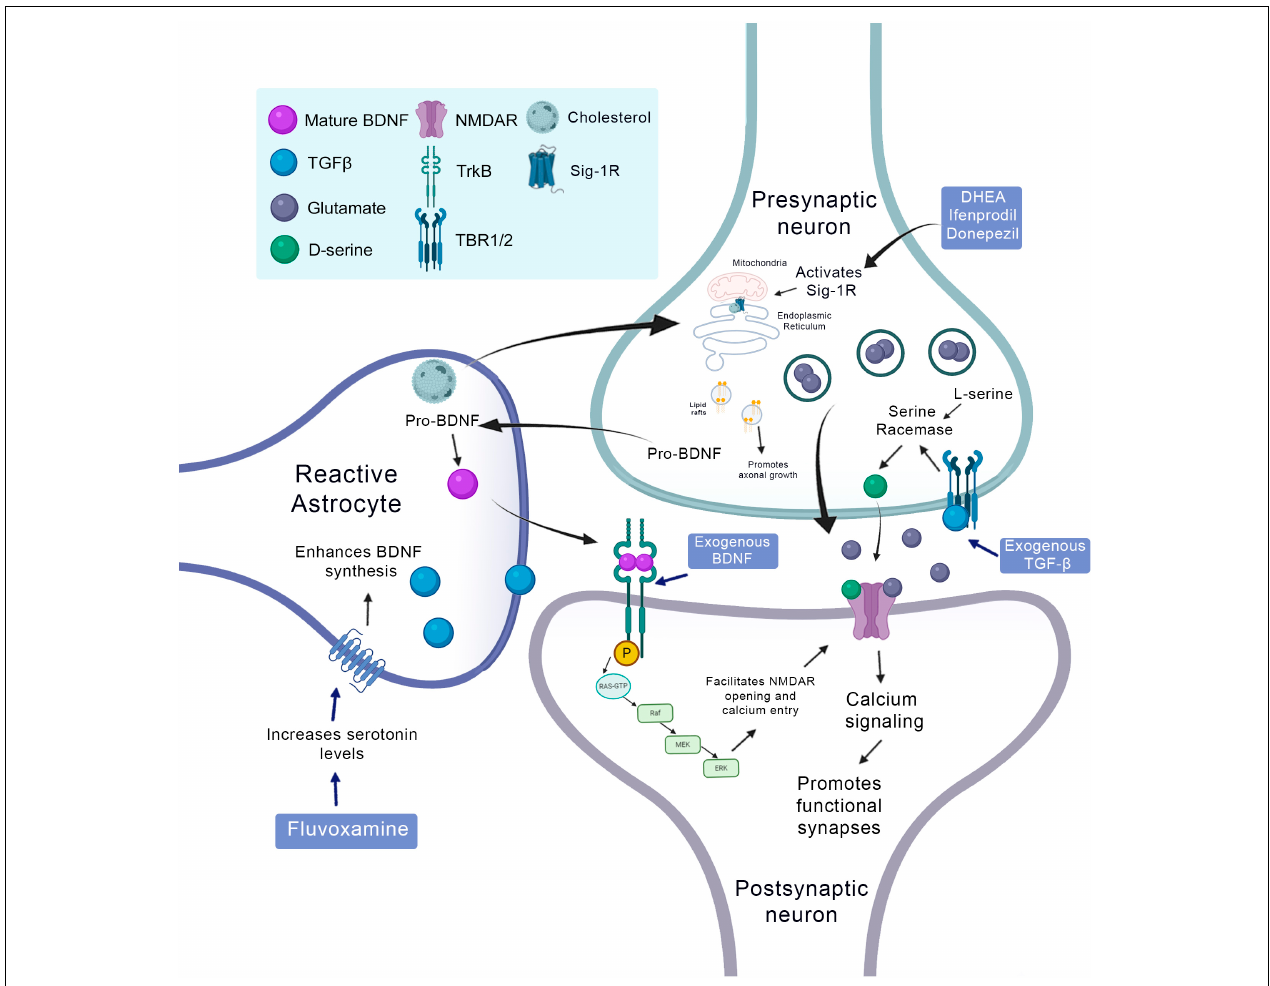
FIGURE 3 | Synaptogenic factors involved in neurorepair in the context of the CNS injury and therapeutic strategies to promote it. Cholesterol released by the astrocyte binds to the sigma-1 receptor and promotes axonal growth. BDNF is produced in the presynaptic neuron and is transformed into mature BDNF in the astrocyte, binds to the TRKB receptor in the postsynaptic neuron and induces its phosphorylation and facilitates the opening of NMDA receptors. The TGF released by astrocytes binds to its TBR1/2 receptor at the presynaptic terminal and activates the serine racemase that converts L -serine to D -serine, which is released in the synaptic cleft and acts on NMDA receptors promoting the formation of functional synapses. The use of fluvoxamine increases the levels of serotonin that will stimulate synthesis and BDNF by the astrocyte. DHEA, ifenprodil and donepezil, are agonists of the sigma-1 receptor. The administration of exogenous BDNF